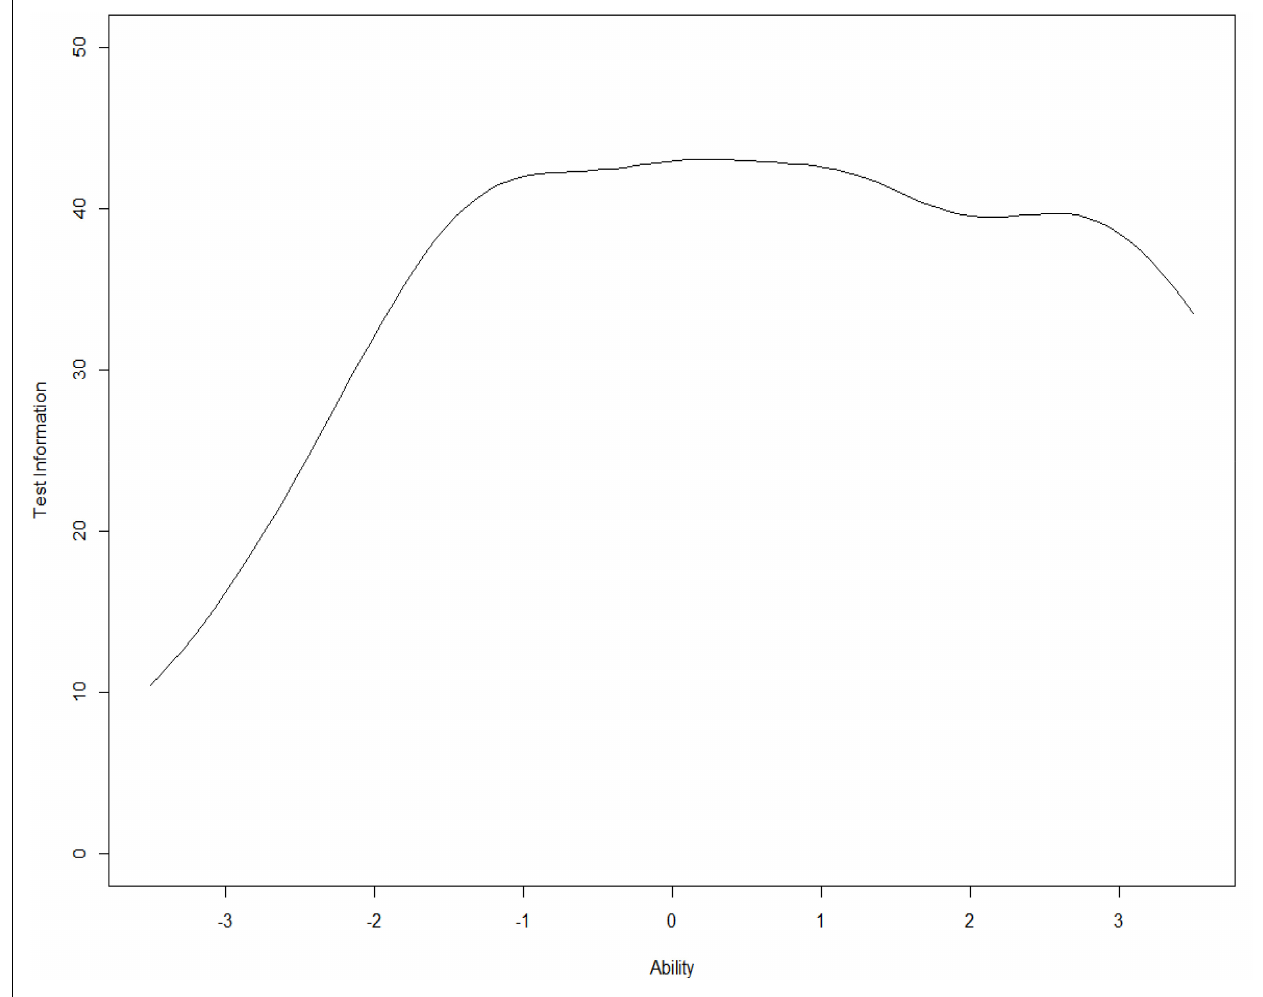
FIGURE 3 | Item bank information